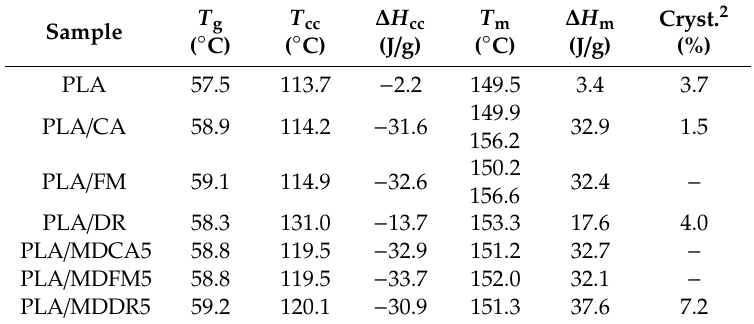
Table 2. Di ff erential scanning calorimetry (DSC) data 1 of poly(lactic acid) (PLA), PLA mix with free chromophores (PLA / CHROs), and PLA mixed with MDs (PLA /